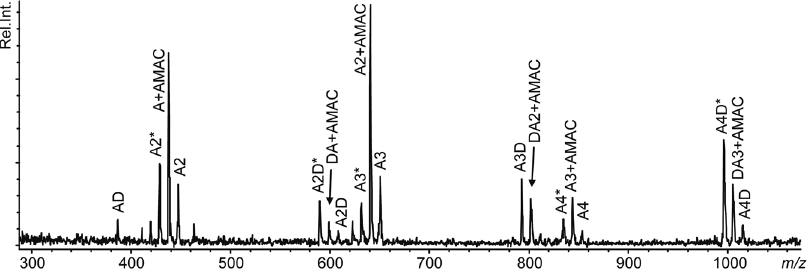
Figure 6. MALDI-ToF MS/MS analysis of AMAC-labelled D 1 A 5 . Several compounds occur in several forms (i.e. multiple masses), due to the loss of water (labelled * ) during fragment formation. Abbreviations: A, N - acetylglucosamine; D, glucosamine; AMAC,